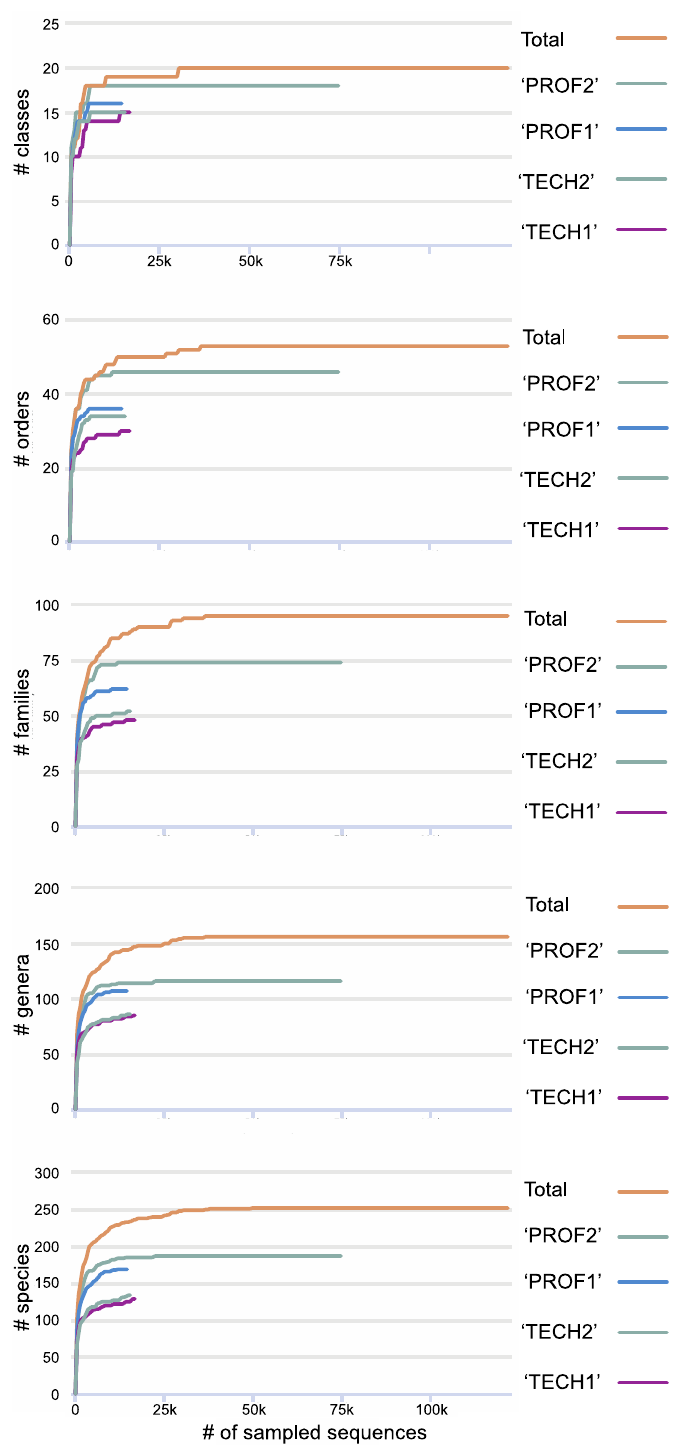
Figure 4. Accumulation curves at various taxonomic levels—class, order, family, genus and species—for each of the four sampling efforts (see Table 1 for summary). Accumulation curves for the pooled samples are represented by the orange ‐ colored lines that are marked “Total”.